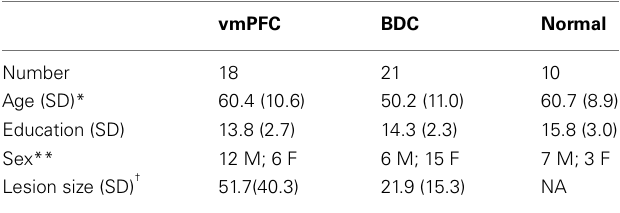
Table 1 | Demographic and neuroanatomical data.